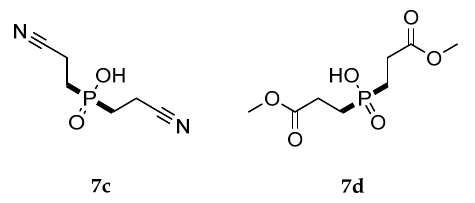
Figure 6. Phosphinic acid derivatives 7c and 7d .